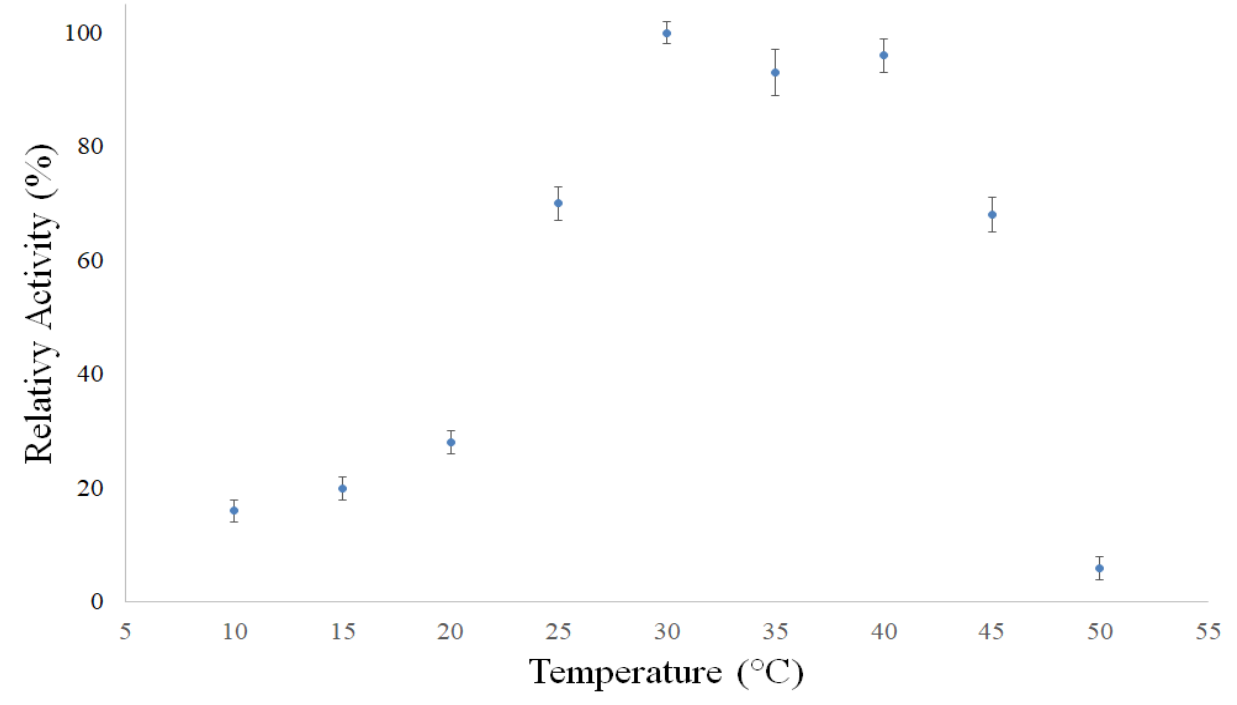
Figure 9. Effect of temperature on the bromelain purified from pineapple at pH 7.